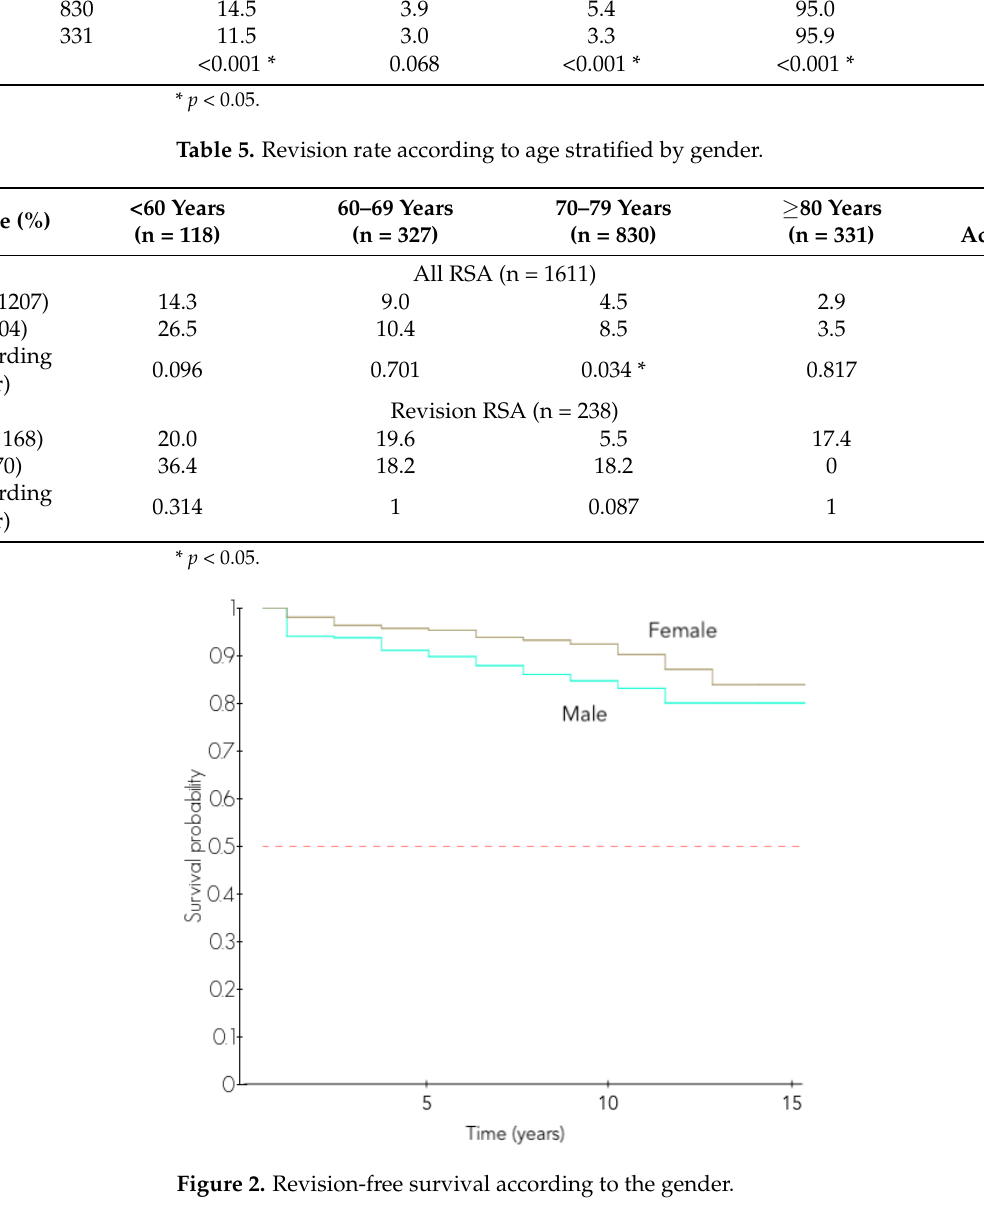
Figure 3. Revision-free survival of 239 revision RSA according to gender. A younger age at surgery was associated with higher rates of complications and re- visions: patients younger than 60 years at the time of RSA had a 10-year survival of 75.7% while patients between 60 and 69, 70 and 79 and over 80 years had a 10-year survival of 88.8%, 91.3% and 94.3% respectively ( p < 0.001, Table 4, Figure 4).